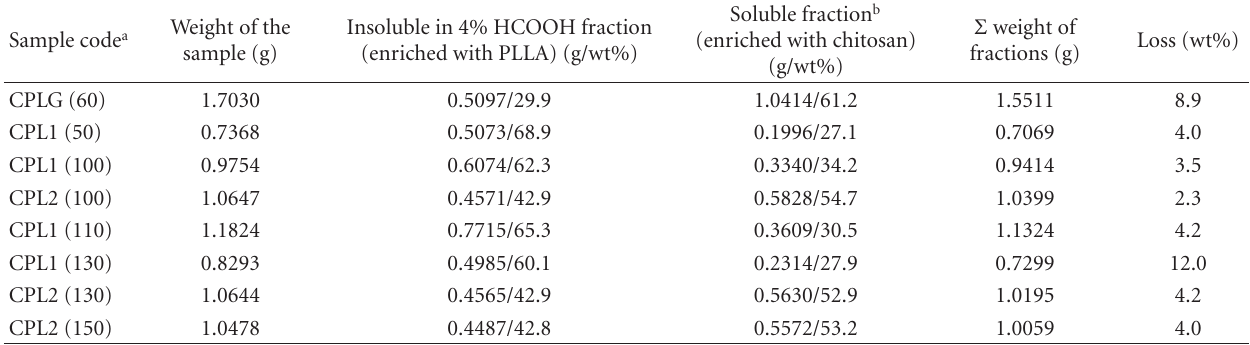
Table 1: Fractionation data for Chitosan-polyester blends obtained at various temperatures. CPL1 blend contains 40wt% of chitosan. CPLG and CPL2 blends contain 60 wt% of